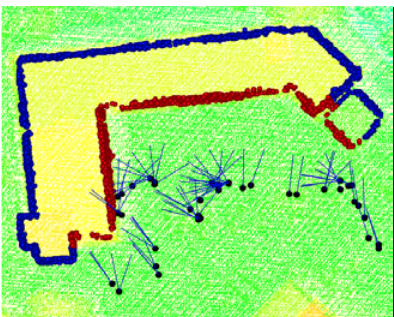
Figure 4. Extraction of visible part of the building outlines by using image pointing information, normal and FOV. Red points show the visible part corresponding to cameras and blue points show the invisible part.